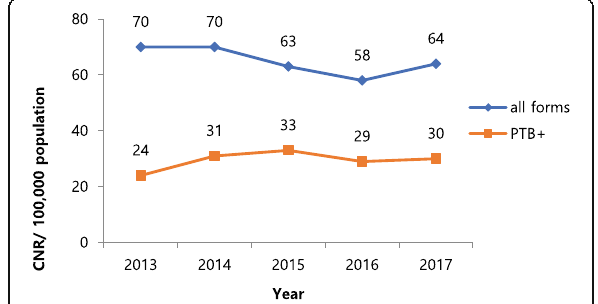
Fig. 1 Overall trends of TB case notification rate, 2013 – 2017